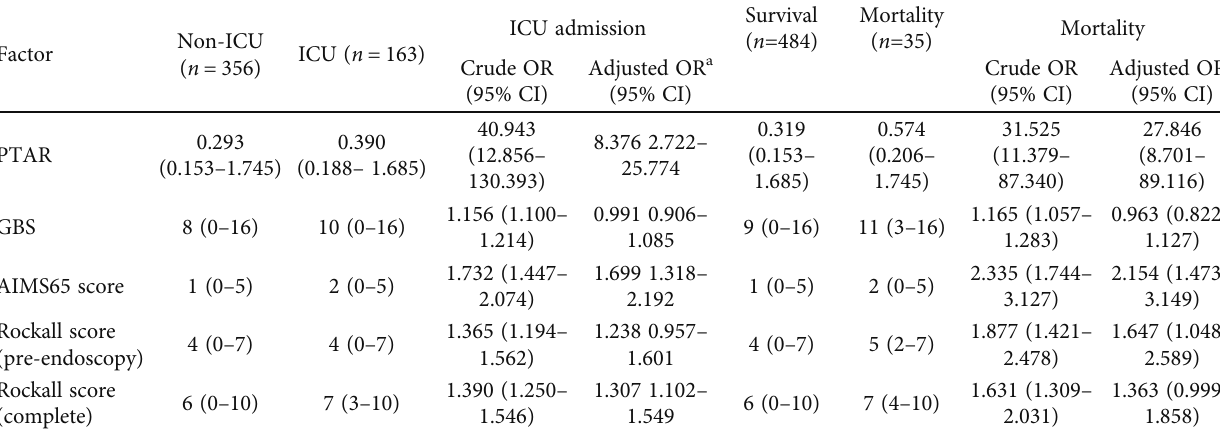
Table 2: In fl uencing factors of ICU admission and mortality.